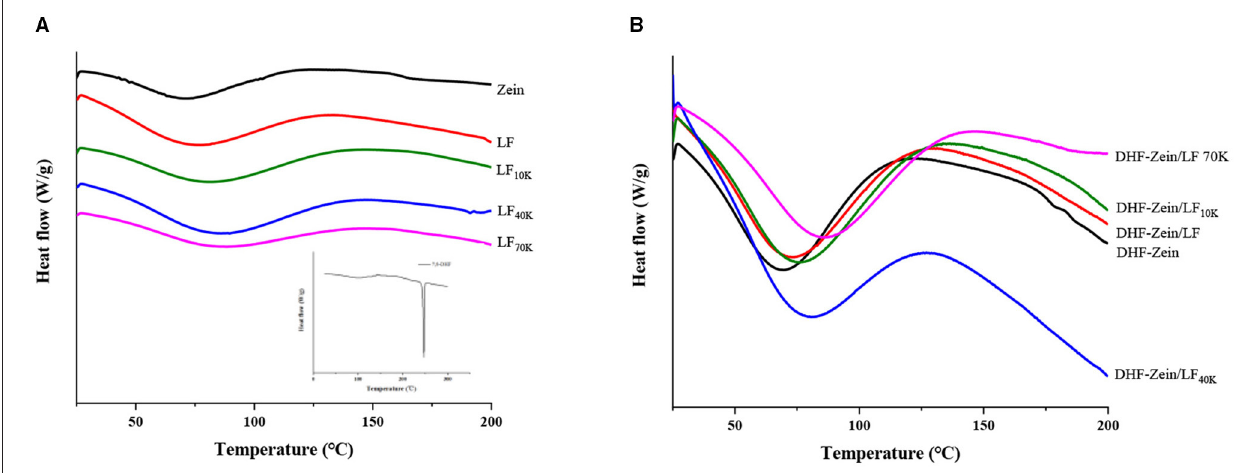
FIGURE 5 | Differential scanning calorimetry (DSC) analysis of samples, such as individual zein, LF, glycosylated LF, and 7,8-DHF (A) , DHF-zein, DHF-zein/LF, DHF-zein/LF 10K, DHF-zein/LF 40K, and DHF-zein/LF 70K (B)